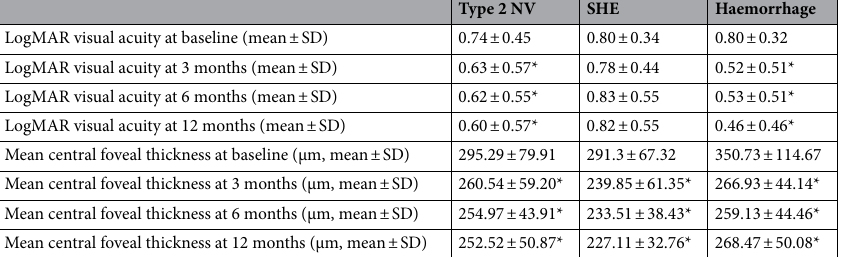
Table 3. Visual acuity and central foveal thickness according to the SHRM components. *Compared with baseline: p < 0.05. SHRM subretinal hyperreflective material, SD standard deviation, NV neovascularization, SHE subretinal hyperreflective exudation.